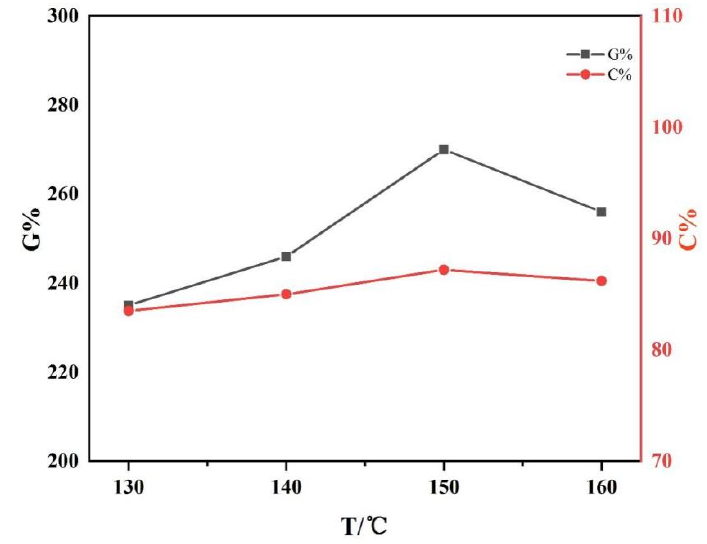
Figure 3. Grafting rate and monomer conversion of CDA–g–PLLA at different reaction temperatures under the reaction of L-LA/CDA feeding mass ratio of 4:1 for 90 min.